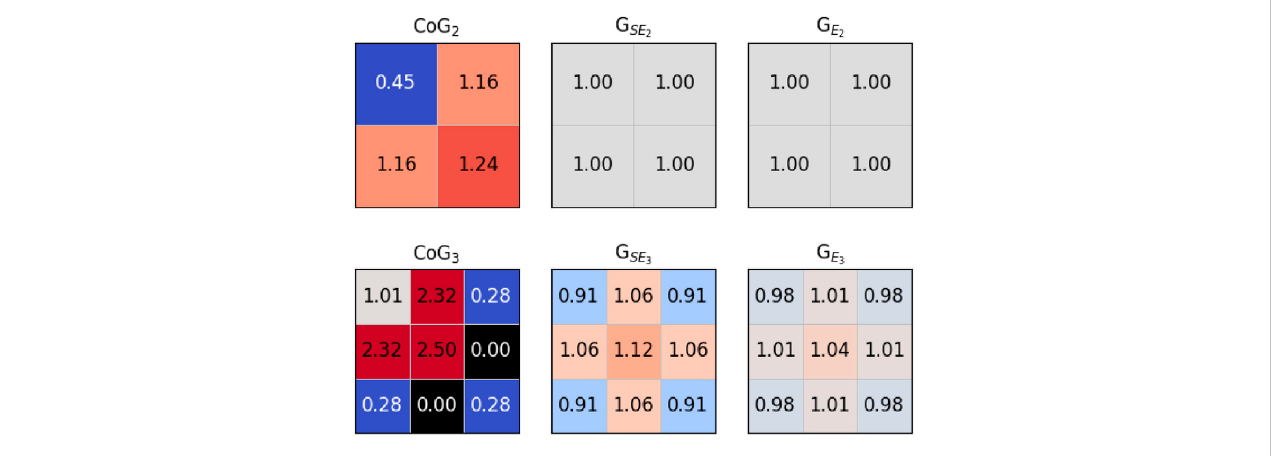
FIGURE 6 Sub-pixel response maps for each of the probed processing methods with an oversampling factor higher than 1.